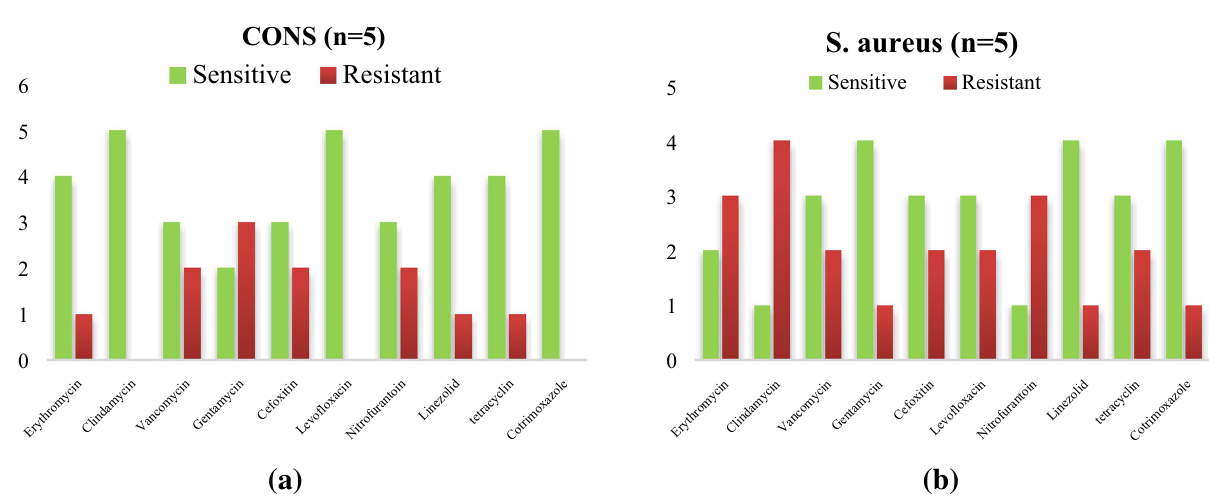
Figure 5. ( a ) Antibiogram of CoNS isolated from medical devices in NICU. ( b ) Antibiogram of S.aureus isolated from medical devices in NICU. Equal no of a CoNS and S.aureus isolated from NICU and both of them show a good sensitivity pattern for linezolid, co trimoxazole, vancomycin, levofloxacin and in each isolates 2 MRSA isolates were detected.